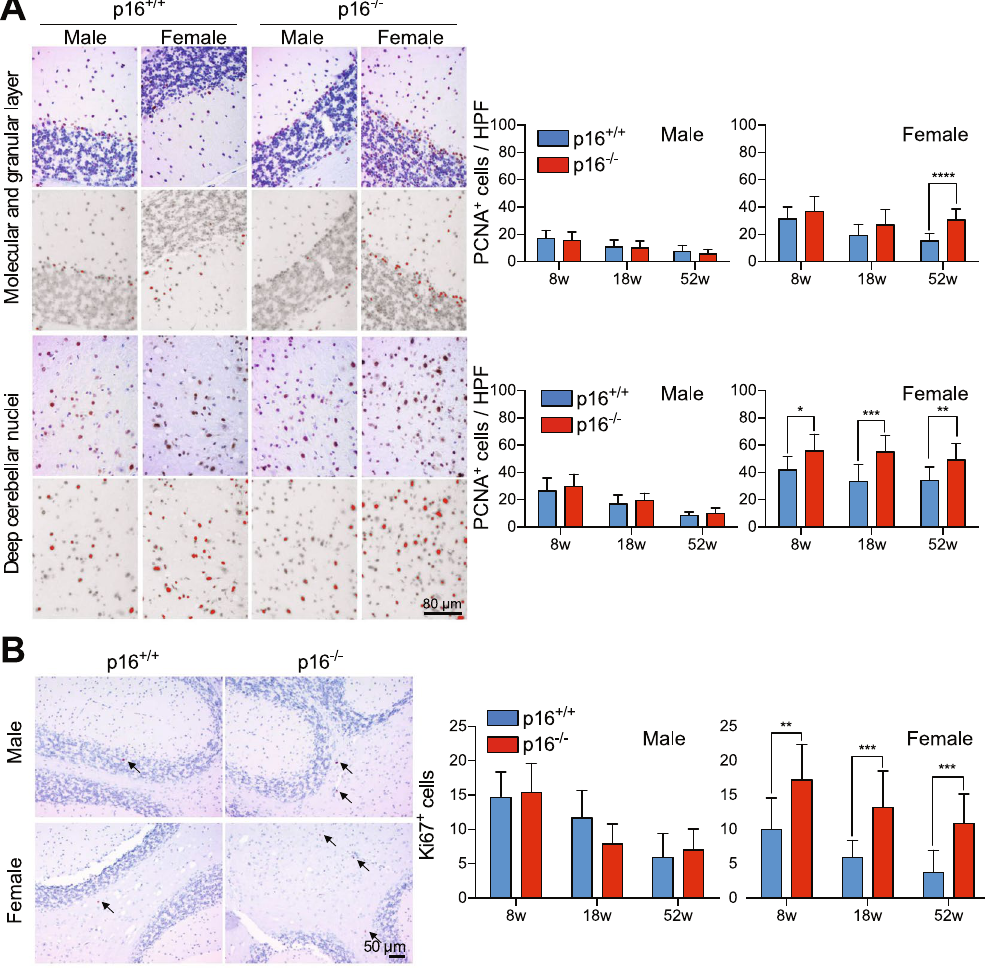
Figure 4. p16 Ink4a deficiency promotes proliferation of neural cells in the cerebellum of female mice only. ( A , B ) Cerebellum sections from p16 + / + and p16 − / − FVB male and female mice were stained with anti-PCNA ( A , n = 15) and anti-Ki67 ( B , n = 9–15), and stained cells in the cerebellum and in deep cerebellar nuclei (brown) were counted in Image J as red dots in a gray background. HPF, high power field. Results are mean ±